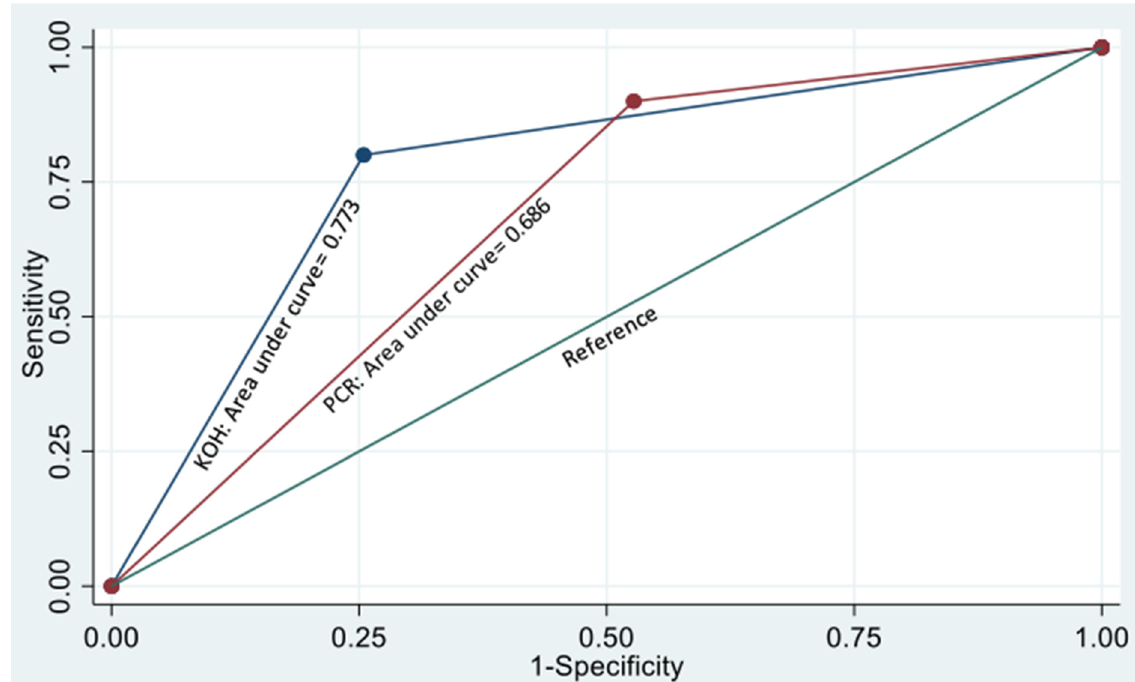
Figure 5. Receiver Operating Characteristic (ROC) Curve. KOH+CFW: ROC area: 0.7727. PCR: ROC area: 0.686.